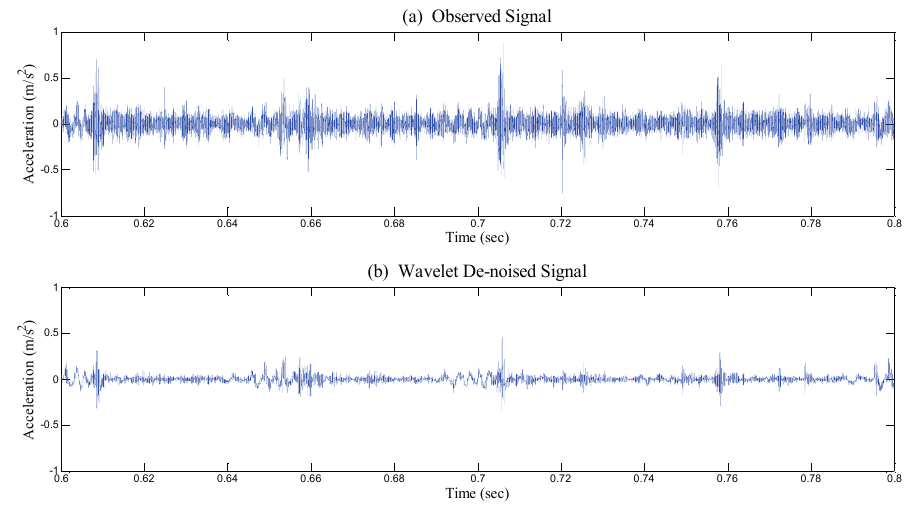
Figure 7. Time-history data of damaged bearing signal ( a ), and wavelet-based de-noised signal ( b